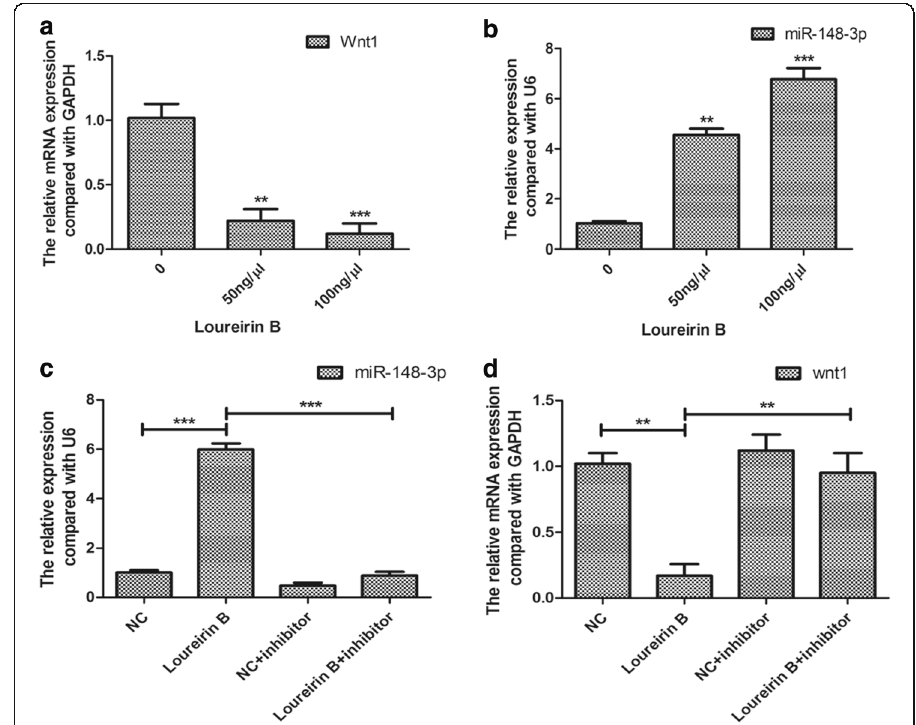
Fig. 4 Loureirin B decreased the expression of Wnt1 via upregulation of miR-148-3p. a and b The expression levels of Wnt1 and miR-148-3p were detected using real-time PCR. c Using the miR-148-3p inhibitor to silence miR-148-3p. d Knockdown of miR-148-3p increased the loureirin B-decreased Wnt1 mRNA level detected using real-time PCR. Data are the means ± SEM from four independent experiments. * p <0.05; ** p <0.01; *** p